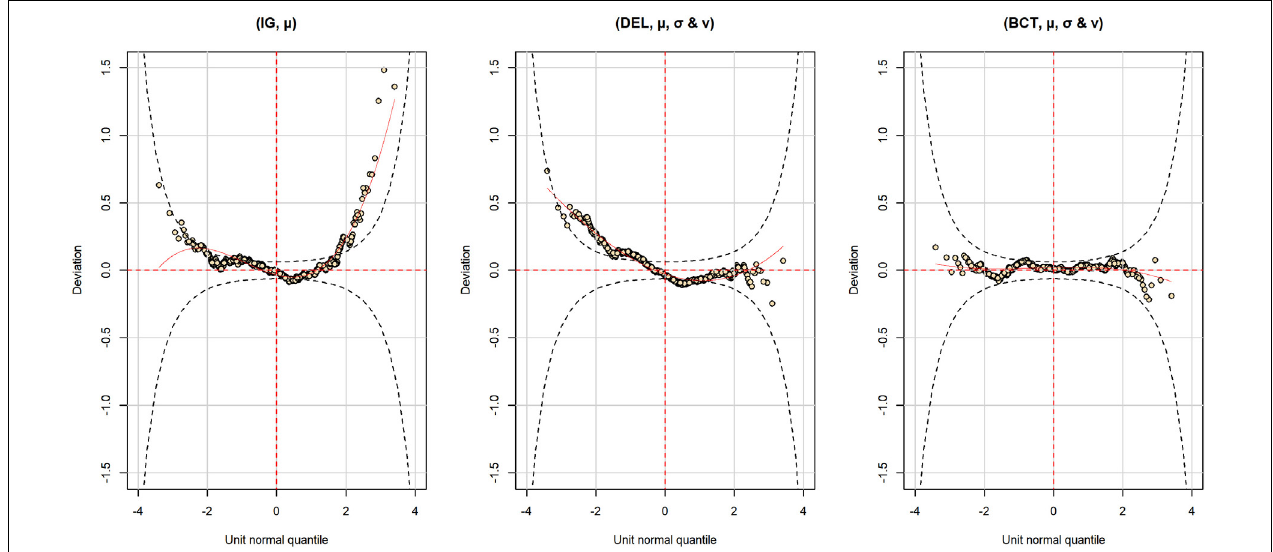
FIGURE 7 | Detrended quantile–quantile plots – also known as worm plots – of the normalized quantile residuals for the (IG, µ ), (DEL, µ , σ , and ν ) and (BCT, µ , σ , and ν ) models reported in Table 5